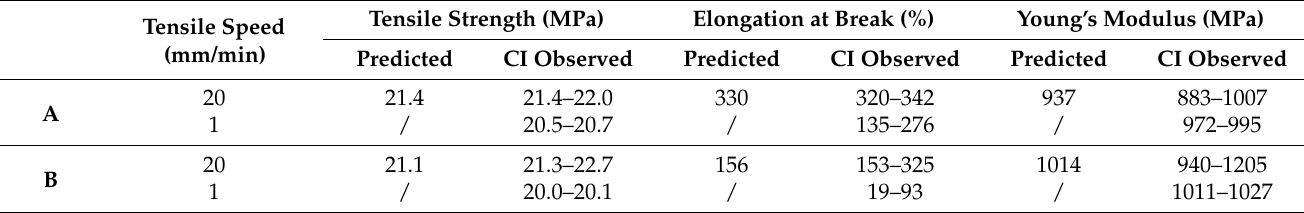
Table 9. Validation of TS, ε and E of PHBHHx samples produced using 2 different processing conditions: (A) P = 145 ◦